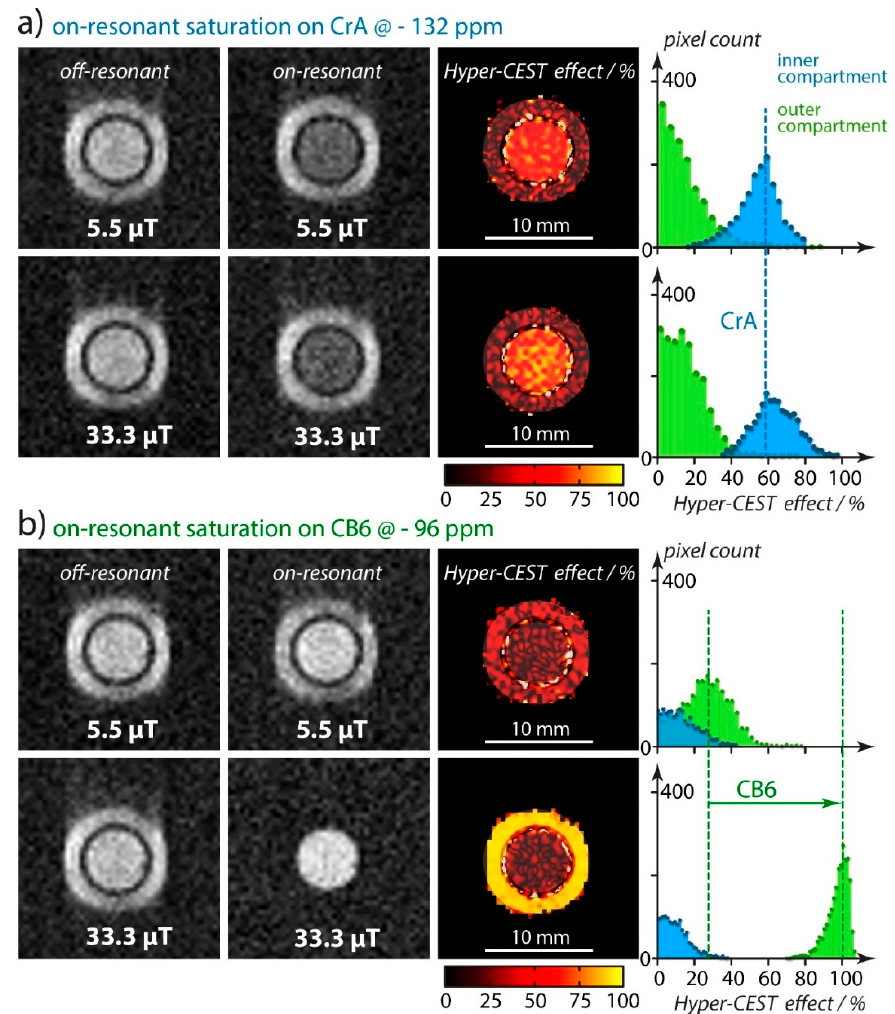
Figure 7. HyperCEST performance of ( a ) CrA and ( b ) CB[6]. This direct comparison of two CEST effects is done with a “double phantom” as depicted in Figure 4c. The histograms represent the distribution of the CEST amplitude throughout the pixels ensemble in the images. The inner compartment with CrA does not improve with stronger saturation power whereas the effect for CB[6] clearly improves for high B 1 . Reproduced from [145], published by The Royal Society of Chemistry, licensed under a Creative Commons Attribution 3.0 Unported Licence (20 December 2019).